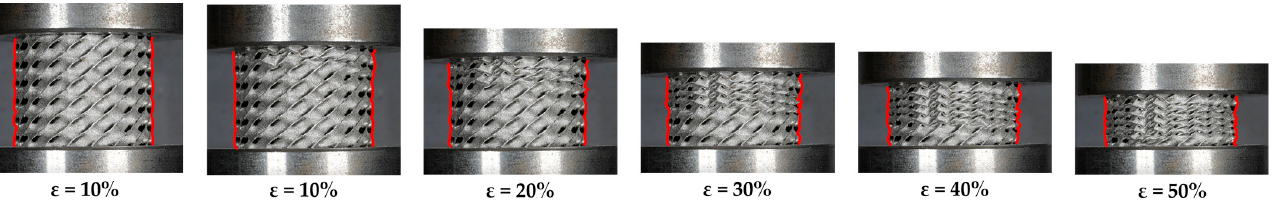
Figure 9. Uniform deformation mode at levels of strain 0%, 20%, 30%, 40%, and 50% for bending- dominated structure on the example of Diamond_9_1_0.64.